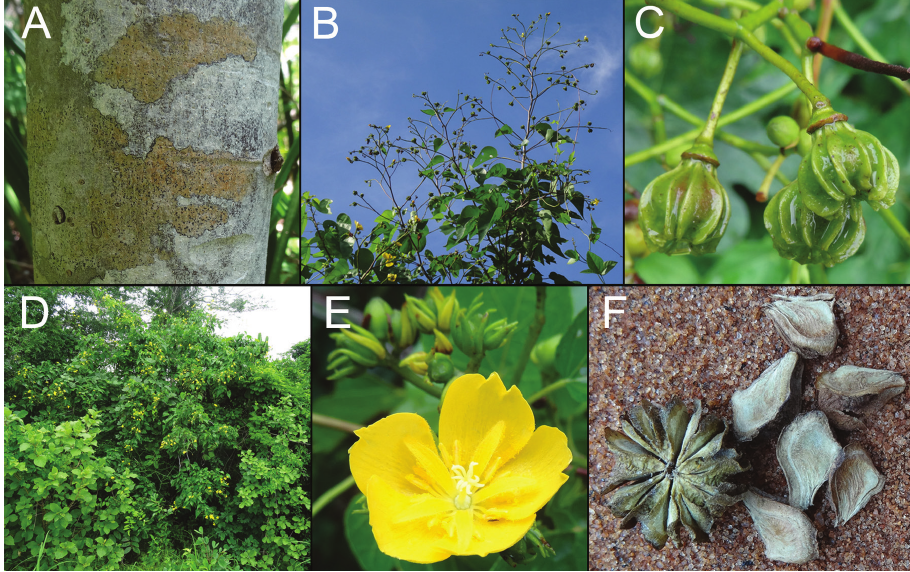
Figure 2. Eriolaena rulkensii . A Trunk and bark B Infructescence C Immature capsules with prominent ridges D Habit (shrub in centre with yellow flowers) E Flower (foreground) with stamens in fascicles of 2(3), each alternating with a ligulate staminode, and a simple style with 10 stigmas; flower buds (back- ground) with 3 epicalyx lobes subtending each calyx F Capsules (mature) with loculicidally dehiscent mericarp-like structures. Photographs: A.J.H.